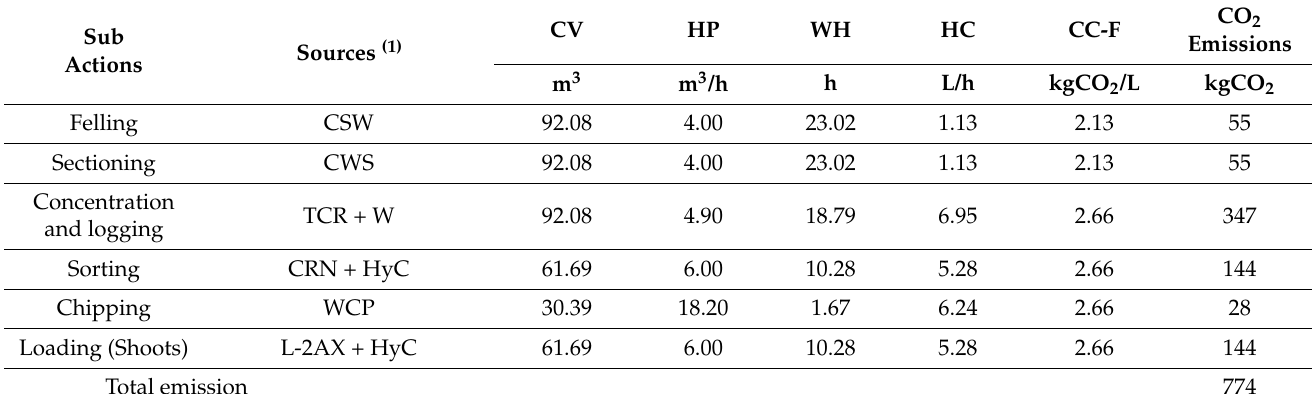
Table 7. Emissions from forest harvesting during the stand thinning. Legend: (1) CSW: Chainsaw; TCR + W: Tractor + Winch; CRN + HyC: Crane + Hydraulic Clamp; HyC: Hydraulic Clamp; WCP: Woodchipper; L-2AX: Lorry (2 axles); CV: Chestnut Volume; HP: Hourly Productivity; HC: Hourly Consumption; CC-F: Conversion Coefficient of Fuel; WH: Working